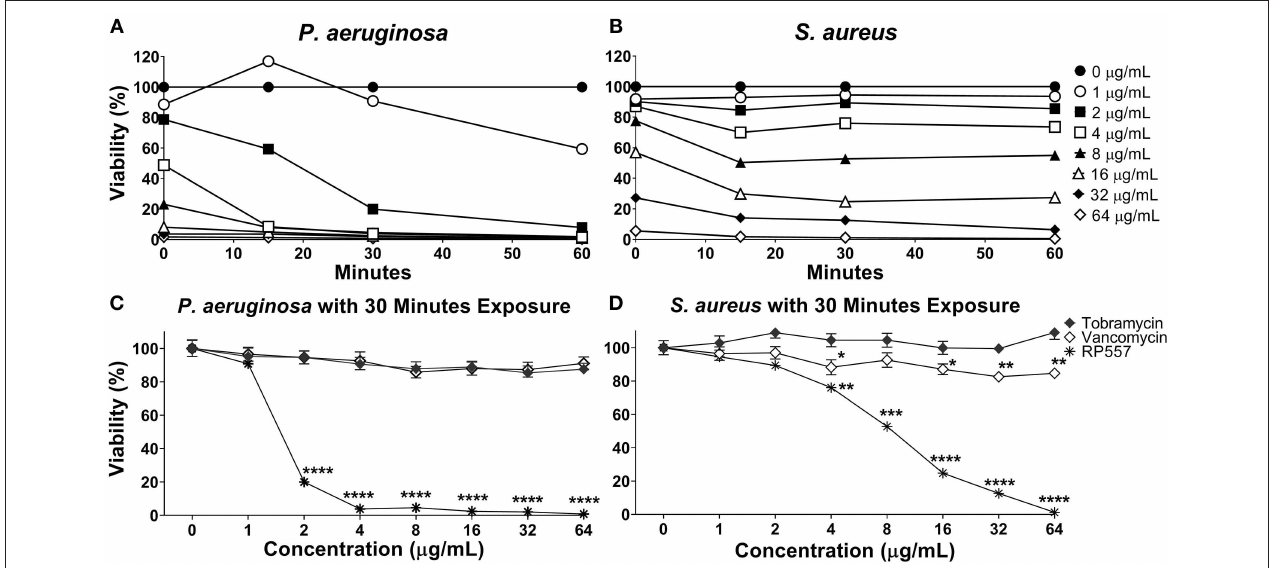
FIGURE 3 | RP557 immediately destroys P. aeruginosa and S. aureus in an increasing dose-dependent manner. The bactericidal effectiveness of RP557, tobramycin and vancomycin were evaluated against bioluminescent P. aeruginosa 19660 (A) and S. aureus 49525 (B) through 60min of exposure. The concentration dependence of RP557, tobramycin and vancomycin following 30min of exposure with P. aeruginosa and S. aureus is shown in (C,D) , respectively. The bioluminescence of viable cells was quantitated non-invasively with an IVIS Lumina bioimaging system. Bioluminescence reflects bacterial viability as is directly correlated with number of colony forming units. Data represent the mean ± SE of triplicate replicates from two independent experiments; statistically significant (* P < 0.05; ** P < 0.01, *** P < 0.001, **** P < 0.0001), using one-way ANOVA followed by Tukey analysis. For some points, the error bars are shorter than the height of the symbols.